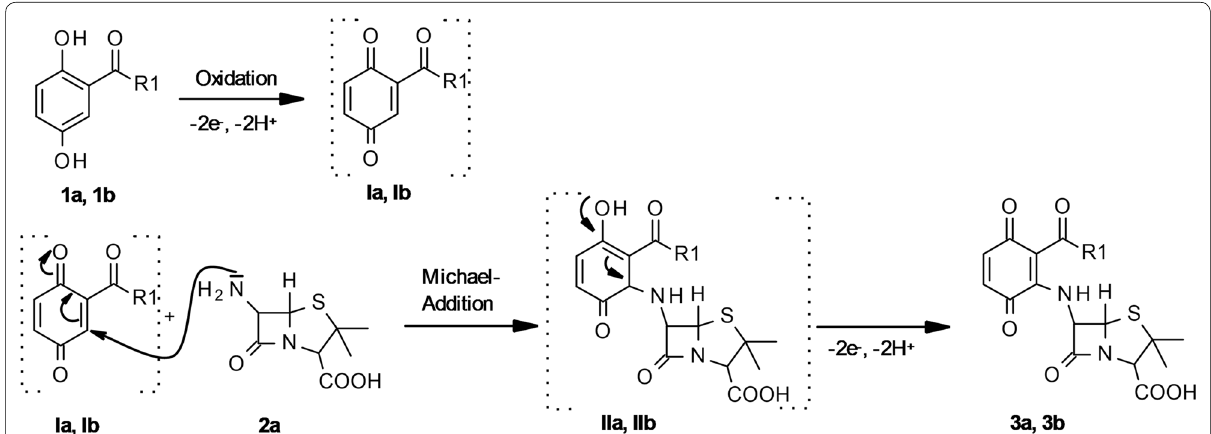
Fig. 2 Reaction mechanism of 2,5-dihydroxybenzoic acid derivatives ( 1a , Ia , IIa , 3a R1 6-aminopenicillanic acid ( 2a )